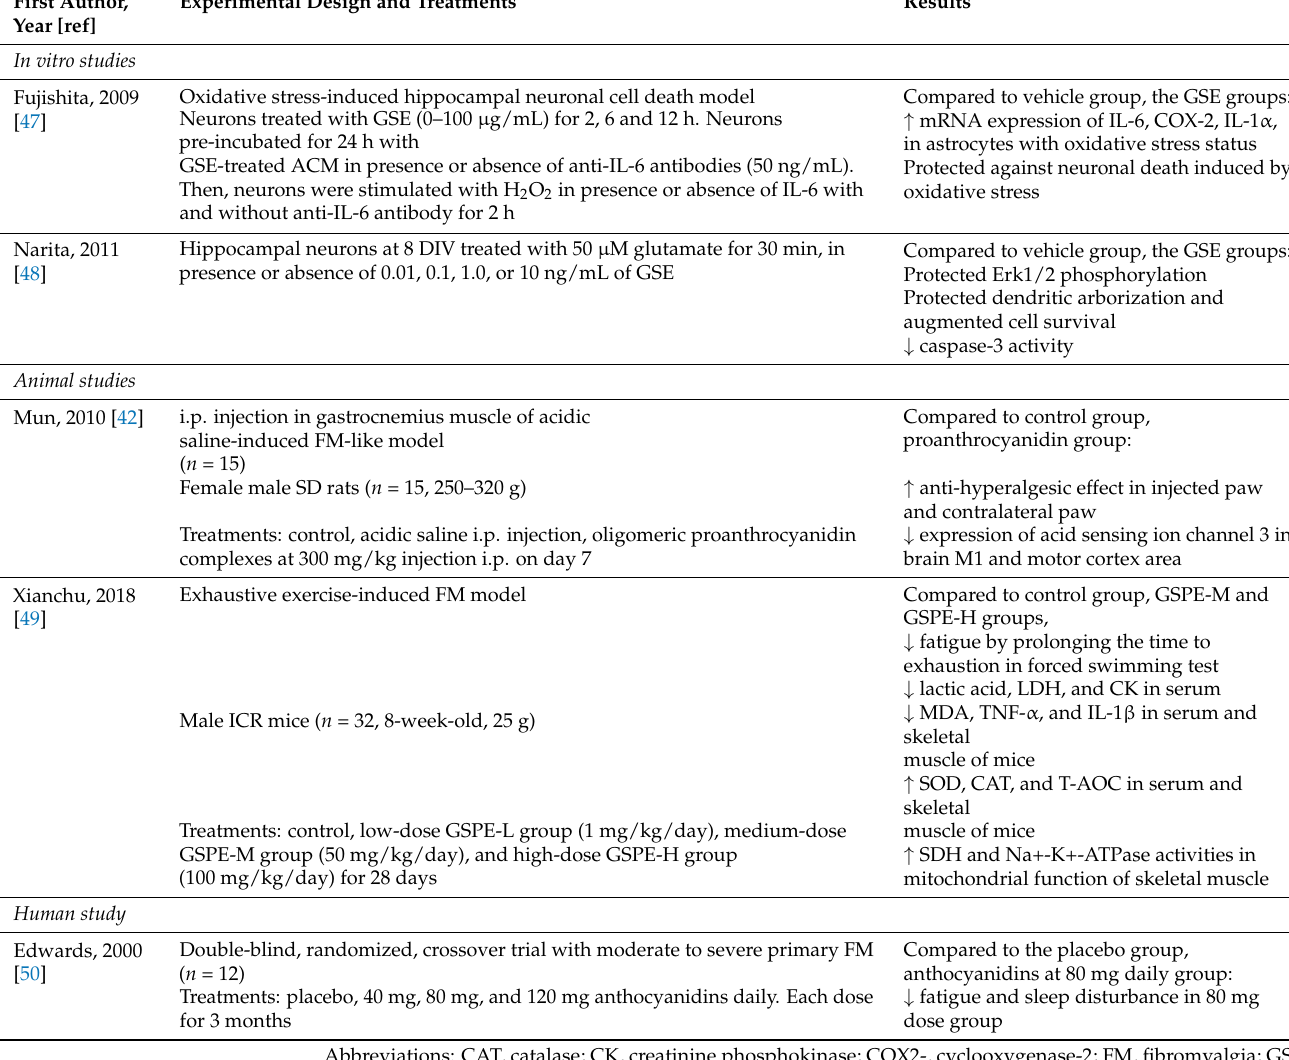
Table 4. Effects of grape seed extract on fibromyalgia-like